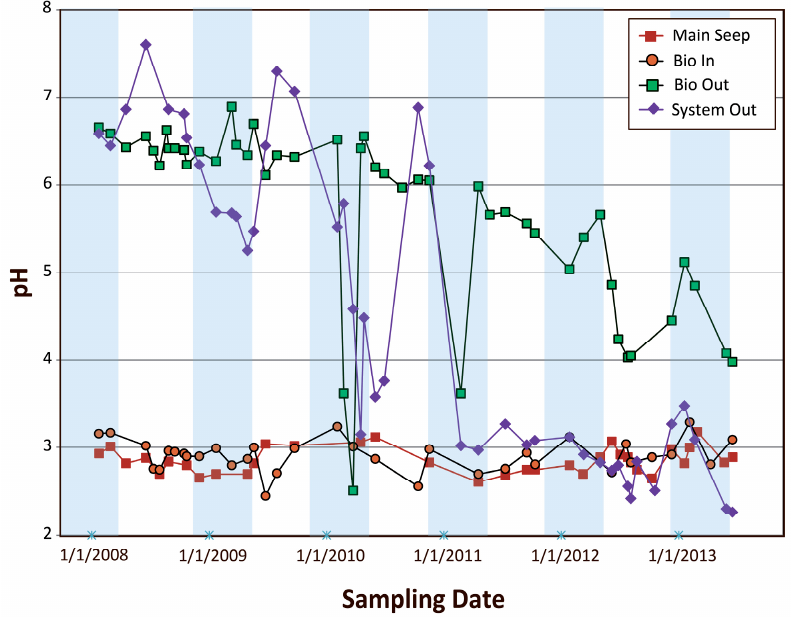
Figure 5. Temporal trends for pH measured in water samples collected at the Main Seep, Bioreactor Inlet (Bio In), Bioreactor Outlet (Bio Out), and the System Outlet (System Out).